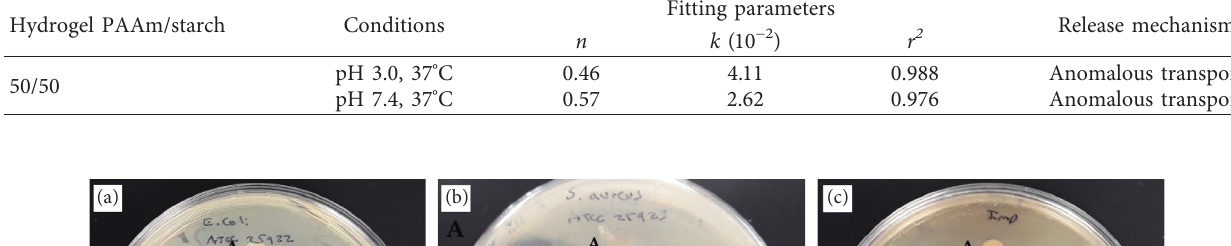
Table 2: Fitting parameters of amoxicillin release data to Korsmeyer–Peppas equation for hydrogels under different conditions. Hydrogel PAAm/starch